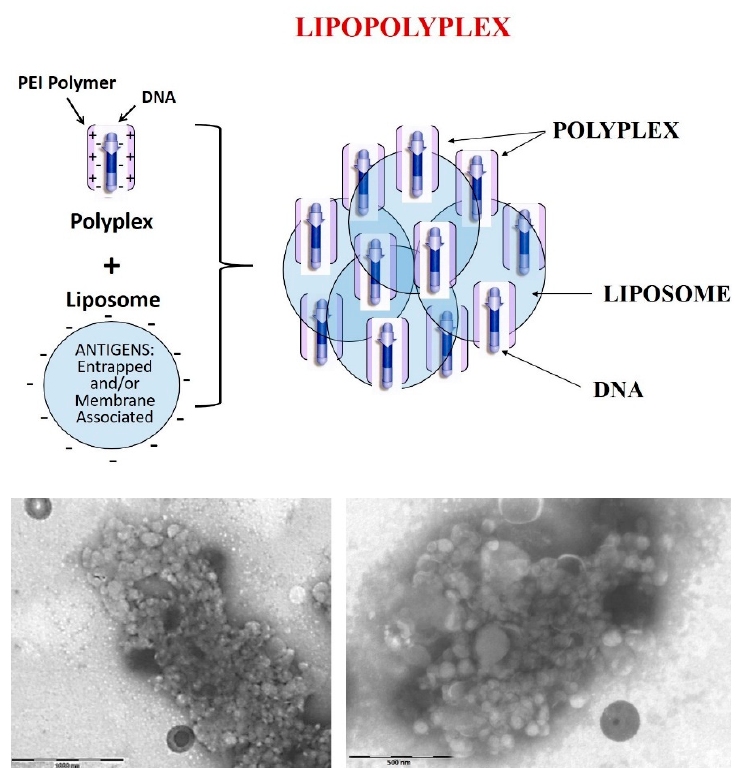
Figure 1. Lipopolyplex structure. Upper: Theoretical diagram of lipopolyplex: Lower panel: TEM images of LPP. Lipopolyplexes images of transmission electron microscopy. Lipopolyplex samples were stained with phosphotungstic acid, which causes negative liposome staining. Complexes size is approximately 1–5 µm in diameter. Left panel scale bar: 1000 nm; right panel scale bar: 500 nm.